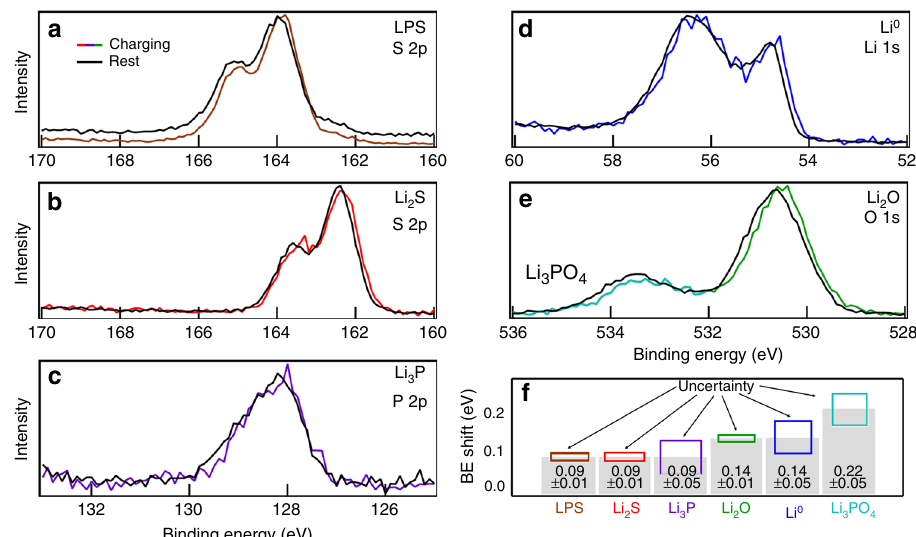
Fig. 5 opXPS determination of chemically resolved cell polarization/overpotential. XPS spectra showing chemically resolved BE shifts caused by applied current bias a before charging (LPS/Li foil ); and b – e after the charging half-cycle (Li/LPS/Li foil ). f Summarizes the current-bias-induced BE shifts extracted by peak fi tting for each of the observed SEI phases. Individual overpotential losses associated with each phase can be determined from these